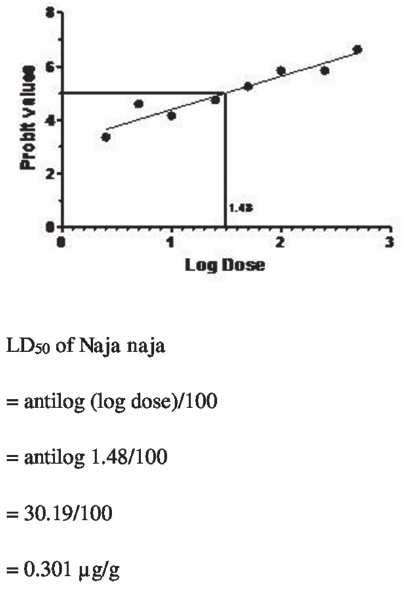
FIGURE 4 - Calculation of lethal dose of Naja naja venom.